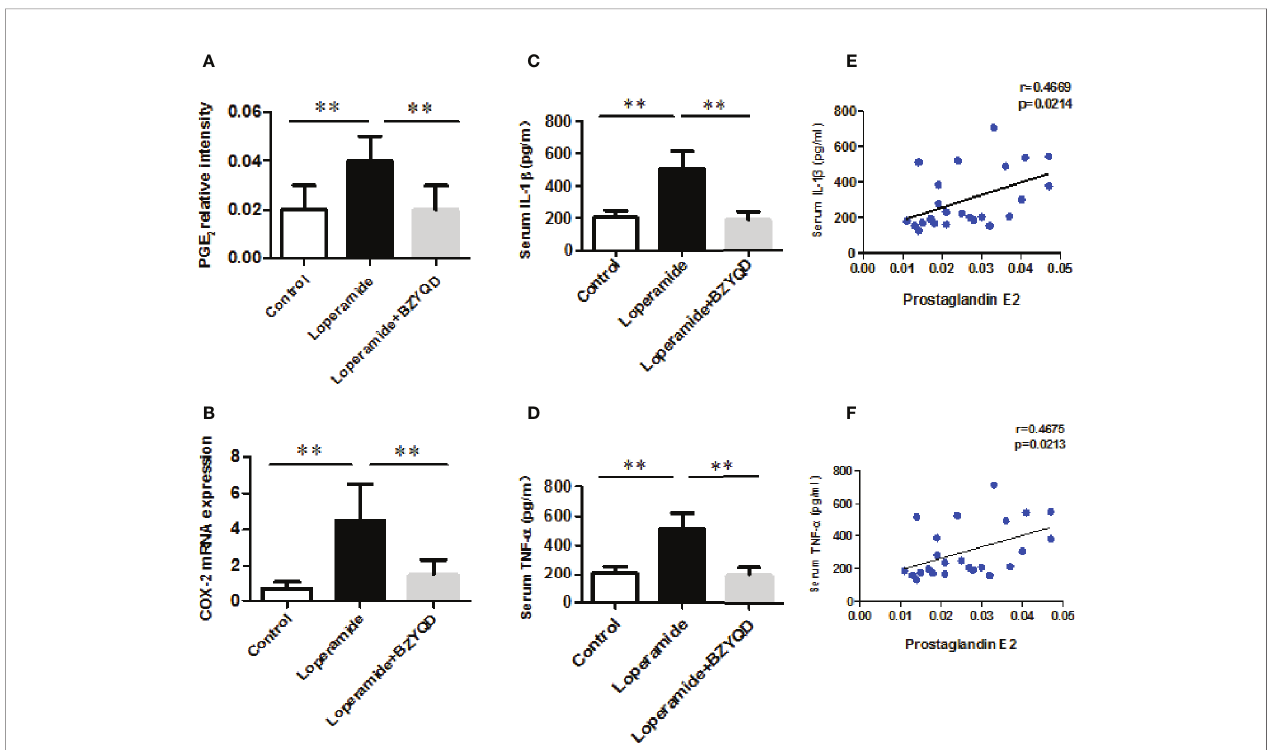
FIGURE 6 | Effect of BZYQD intervention on serum levels of in fl ammatory factors in loperamide-treated rats. (A) Serum levels of prostaglandin E 2 (PGE 2 ) in each group; (B) The mRNA expression of COX-2 in mice colon tissue; (C) Serum levels of IL-6 detected using ELISA in each group; (D) Serum levels of TNF- a detected using ELISA in each group; (E) The correlation between serum levels of IL-6 and serum metabolite PGE 2 ; (F) The correlation between serum levels of TNF- a and serum metabolite PGE 2 ; data are represented as mean ± SD (n = 8). ** P < 0.01 between two groups. Correlation factor (r) and P -value were determined using the Pearson's correlation